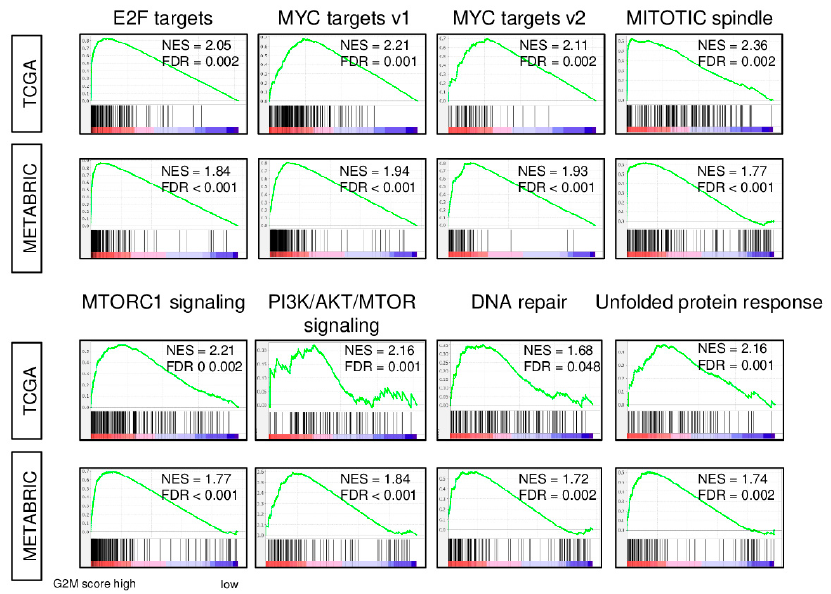
Figure 1. Hallmark gene sets with a significant enrichment in high G2M pathway score tumors. Gene set enrichment plots along with normalized enrichment score ( NES ) and false discovery rate ( FDR ) are shown for the eight gene sets for which enrichment was seen in tumors with high compared with low G2M pathway activity score in both The Cancer Genome Atlas ( TCGA ) and Molecular Taxonomy of breast Cancer International Consortium ( METABRIC ) cohorts. The G2M score was calculated from tumor gene expression as the single-sample gene set variation analysis score for the Hallmark G2M gene set, and the within-cohort median value was used to identify tumors with high and low scores. NES and FDR were determined with the classical gene set enrichment analysis ( GSEA ) method.